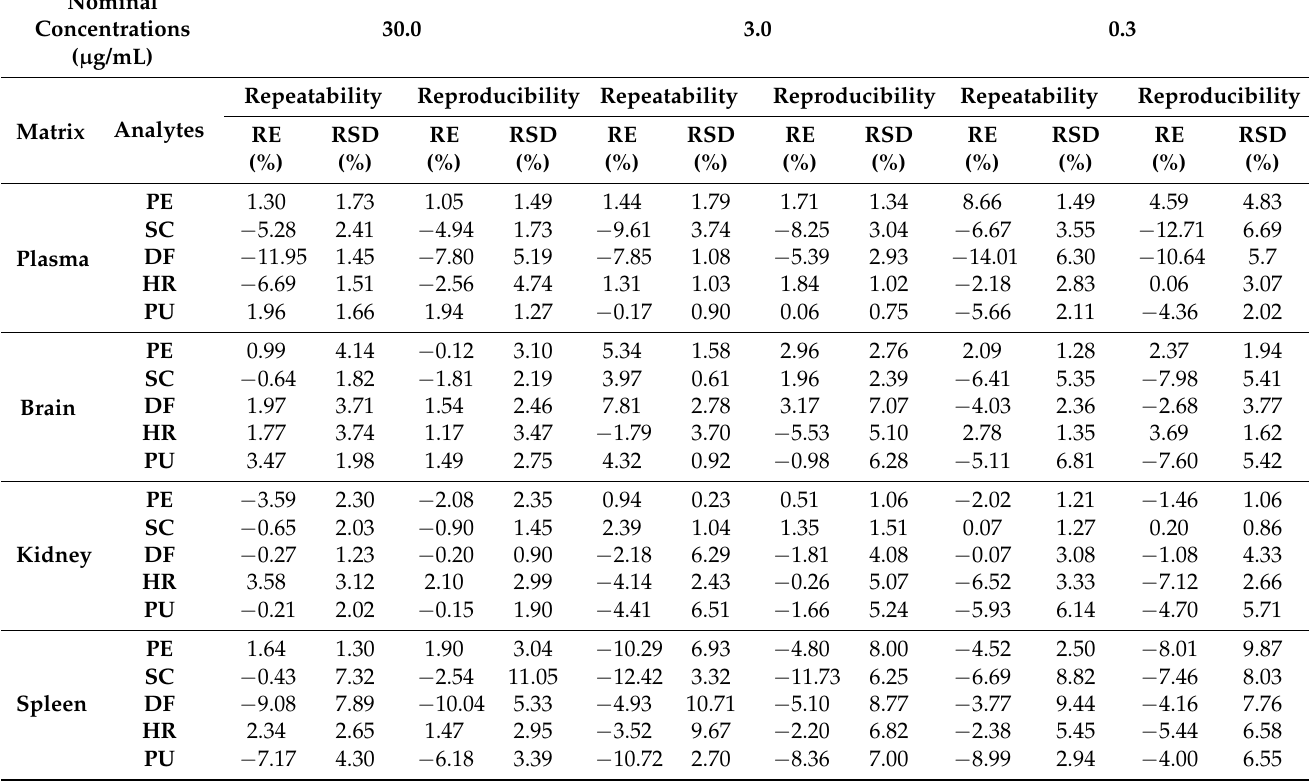
Table 2. Data of accuracy and precision determined for coumarins in plasma and tissue